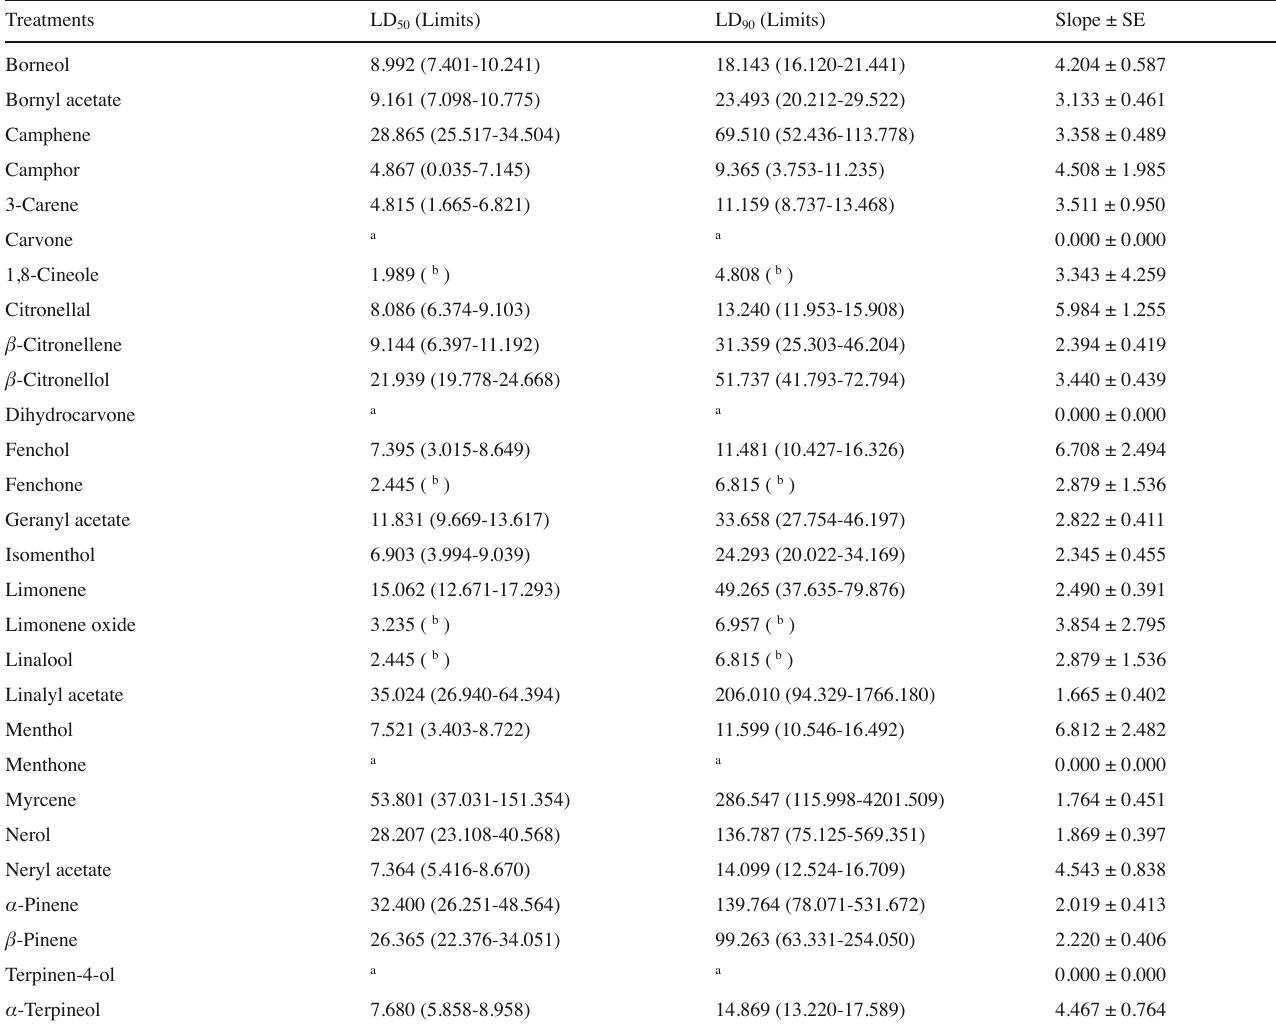
Tab. 2: The 96 h LD 50 and LD 90 values of twenty eight monoterpenes to adults of Sitophilus